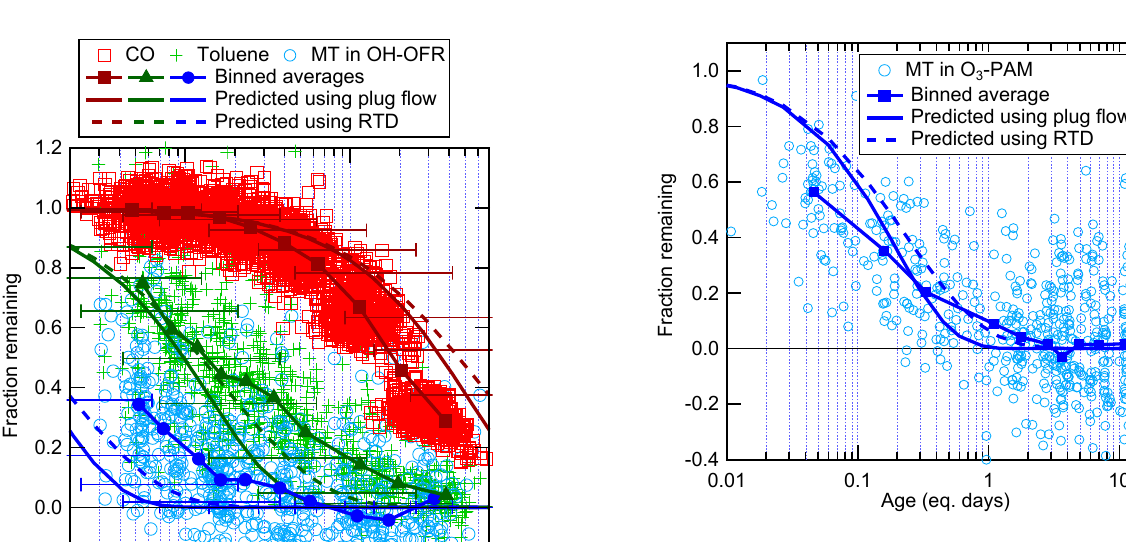
Figure 2. Fraction of ambient MT remaining after O 3 oxidation in the OFR, as a function of photochemical age. Binned averages of the fraction remaining are also shown, compared to the amount predicted to remain assuming either plug flow or using the RTD of particles from Lambe et al.